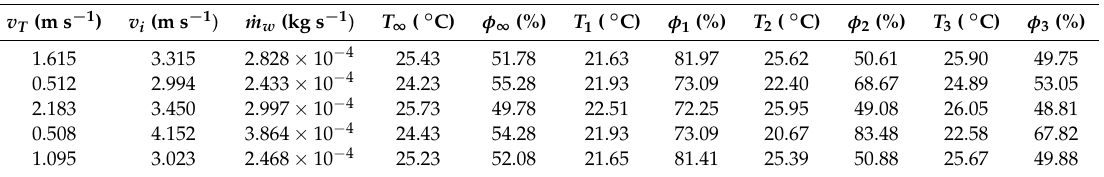
Table 2. Summary of the experimental tests carried